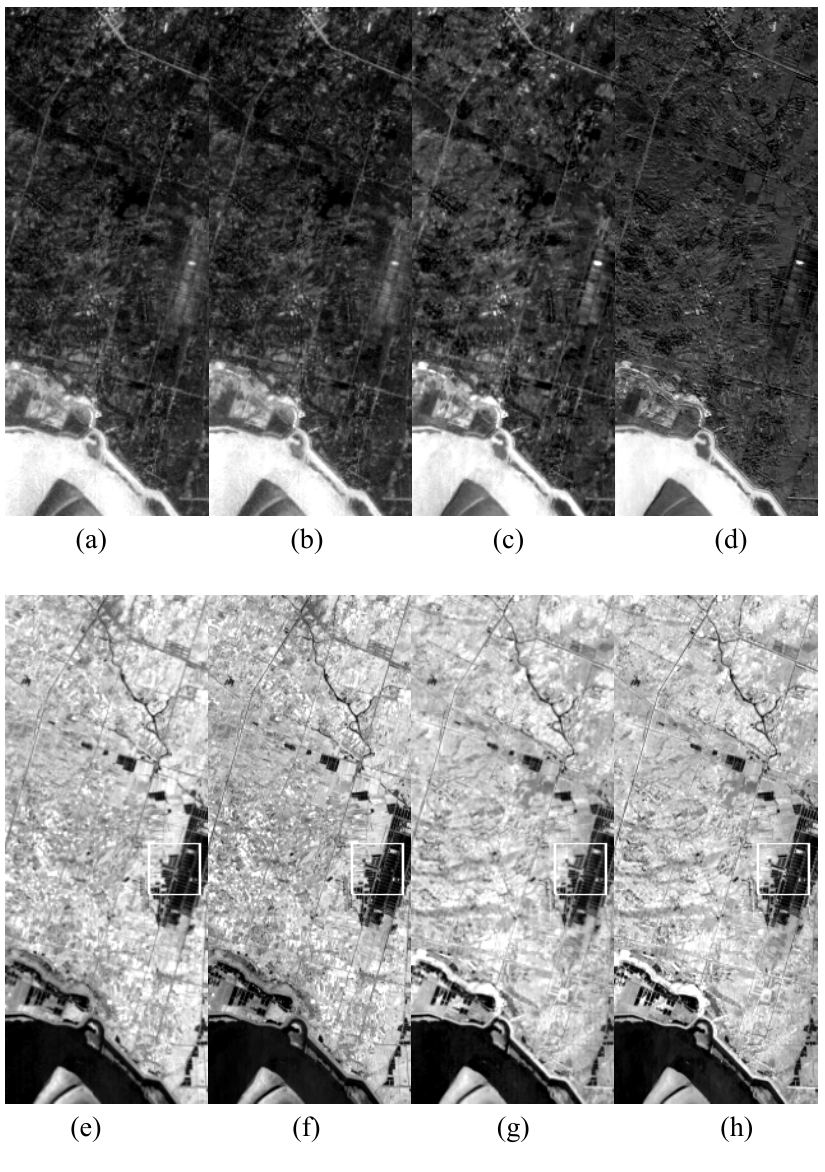
Figure 1 . Visual comparison of simulated Hyperion data and original Hyperion data: (a) and (b) are band 13 of original Hyperion data and simulation Hyperion data, respectively; (c) and (d) are band 19; (e) and (f) are band 94; (g) and (h) are band 148. There are